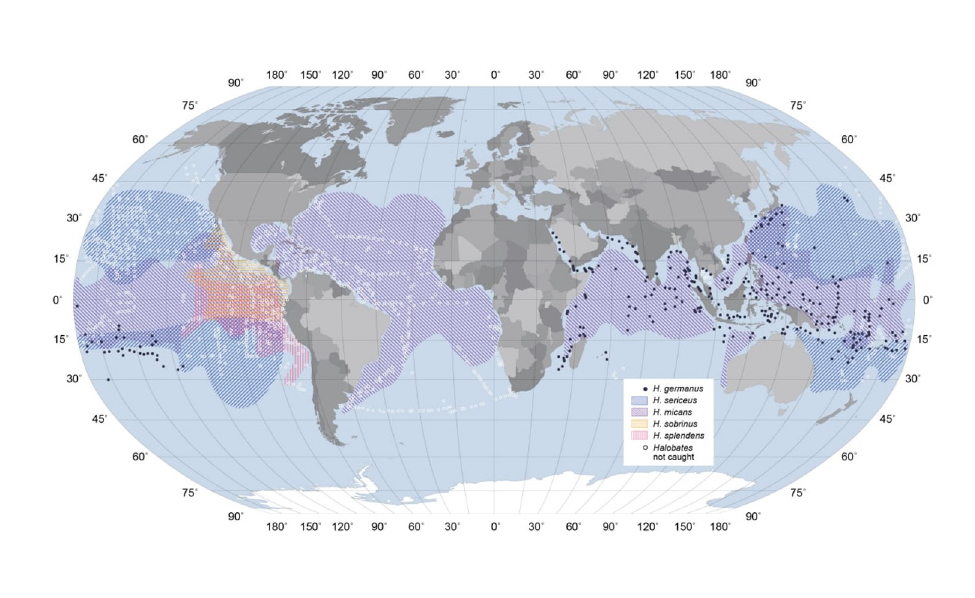
Fig 2. World Distribution of Halobates . The map shown here was compiled with data from > 3,000 samples (LC Collections deposited at ZMUC, now known as Natural History Museum of Denmark) described in [19–21]. Ranges are shown for all species except Halobates germanus , which occurs widely in the Pacific as well the Indian Ocean and seems to prefer more coastal waters. Its distribution is presented as black dots where it has been caught. This difference in presentation is to aid interpretation of the data, as the ranges of the other 4 species overlap in many regions. White open circles represent known stations where no insects were caught. Note: very few collections were made in south Atlantic, Indian or eastern Pacific Oceans. We do not know if Halobates were actually absent from these areas. Halobates micans is cosmopolitan and widely distributed between latitudes 40N and 40S in the Atlantic but only extends to within 15S in the Indian Oceans. It’s range is restricted roughly between 15 N and 15 S in central Pacific Ocean where areas beyond its northern and southern boundaries are occupied by Halobates sericeus [20]. Halobates sobrinus and Halobates splendens (the rarest of the five species) are both confined to the eastern Pacific